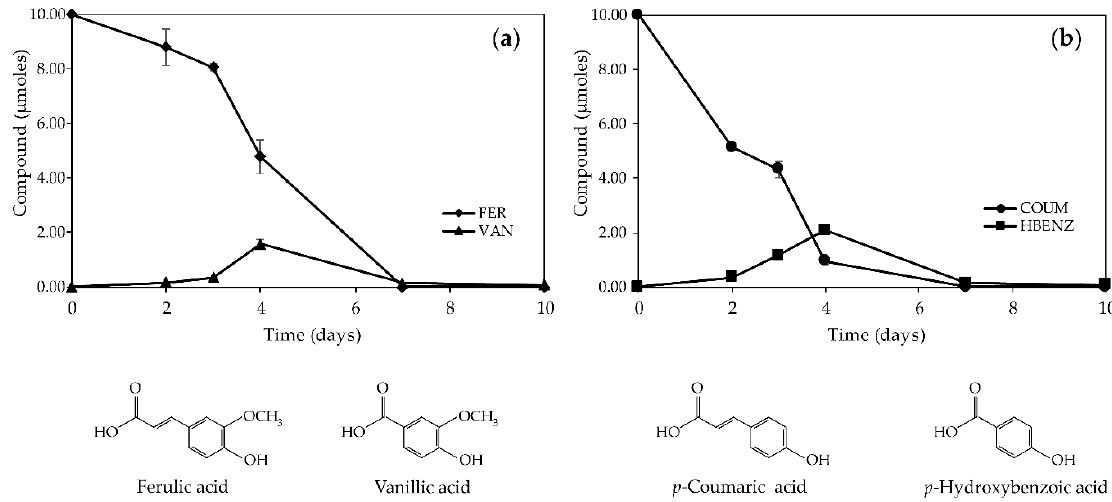
Figure 4. Kinetics and chemical structure of ( a ) ferulic acid (FER), ( b ) p -coumaric acid (COUM), and their metabolites in the supernatants of Penicillium verrucosum cultures supplemented with 0.5 mM of FER and COUM. Values are expressed as means ± standard deviation using five biological replicates.